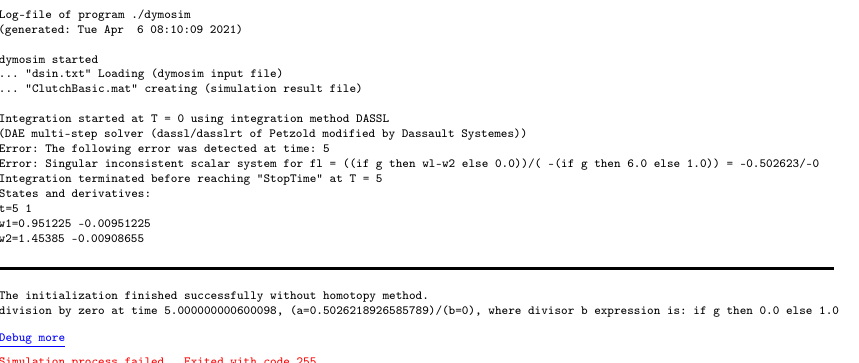
Figure 10. Division by zero exceptions with Dymola 2021 ( top ) and OpenModelica 1.17.0 ( bottom ) occurring when simulating the Ideal Clutch Modelica model.